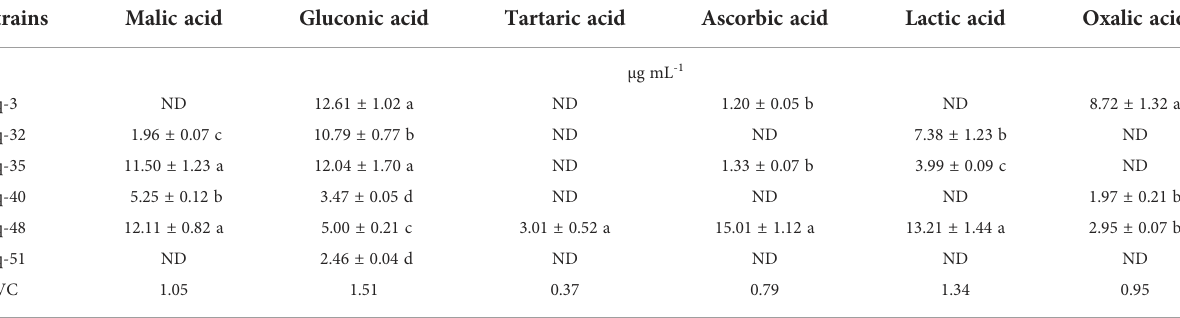
TABLE 4 Production of organic acids by phosphate solubilizing bacterial strains grown in Pikovskya broth amended with tri-calcium phosphate. Strains Malic acid